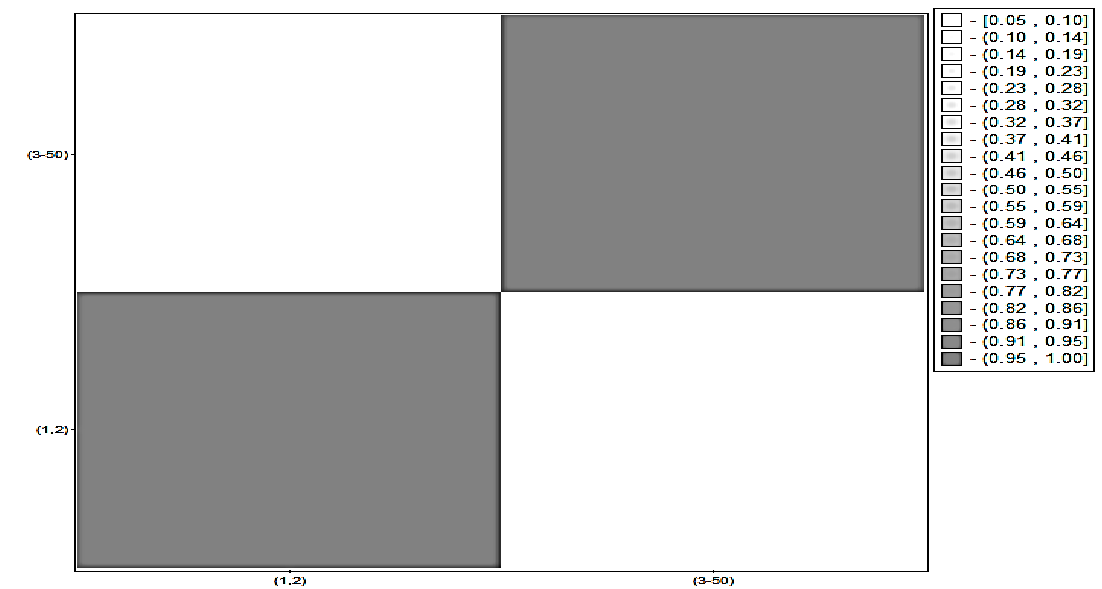
Figure 13. Matrix of w -correlations of the selected 50 eigenvectors of the SVD of the trajectory matrix.